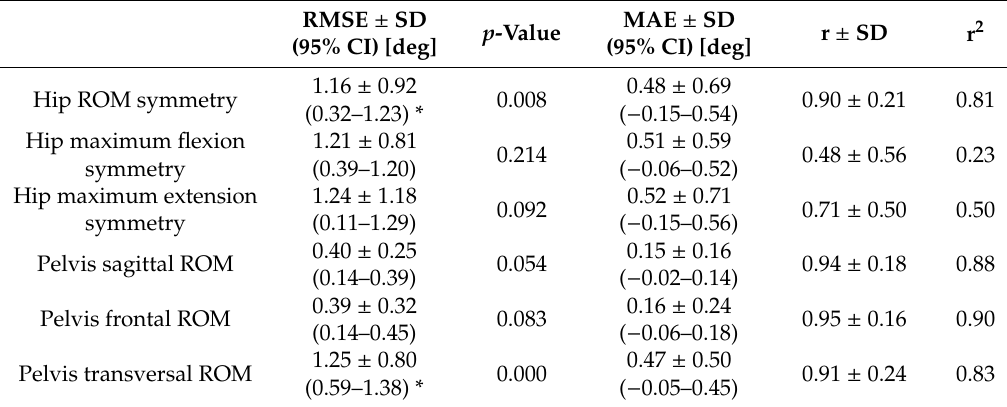
Table 2. Validation results of the feature Set 2 within the THA Group. Shown are the root mean squared error (RMSE) ± standard deviation (SD) (95% confidence interval (CI)), the mean absolute error (MAE) ± SD (95% CI), the pearson correlation coe ffi cient (r) ± SD and the coe ffi cient of determination (r 2 ). An asterisk indicates a significant di ff erence between the THA Group and the Control Group. The corresponding p -values are given. RMSE ± SD